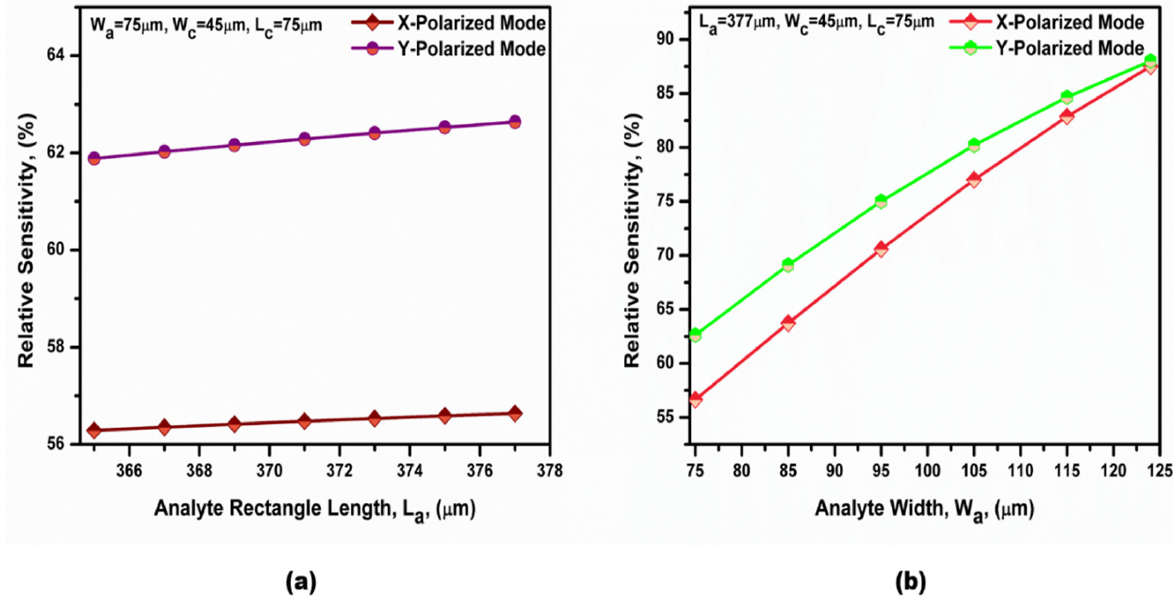
Figure 10. Dependence of the relative sensitivity on ( a ) the analyte rectangle length ( L a ) and ( b ) the analyte rectangle width ( W a ) at a bilirubin concentration equal to 4 µmol/L and f = 0.75 THz.